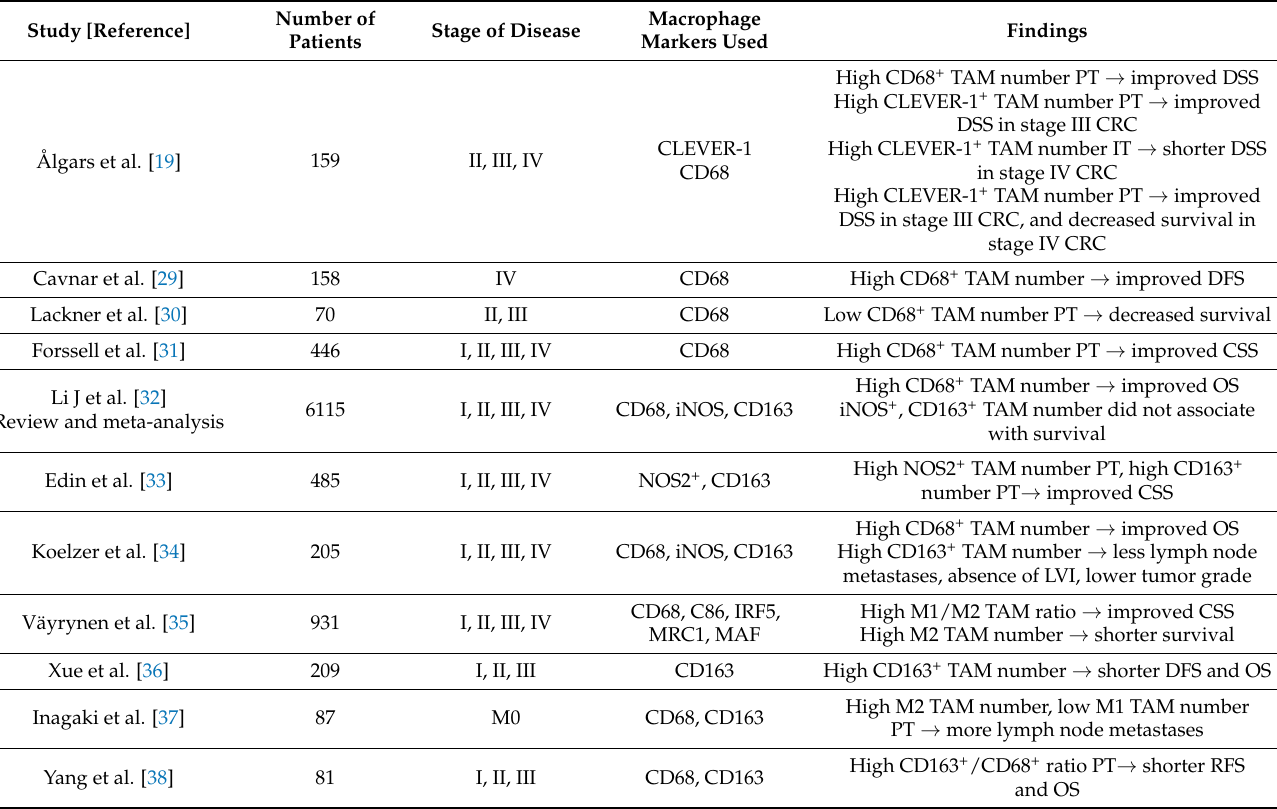
Table 1. The prognostic role of tumor associated macrophages in colorectal cancer according to previous studies. Study [Reference]